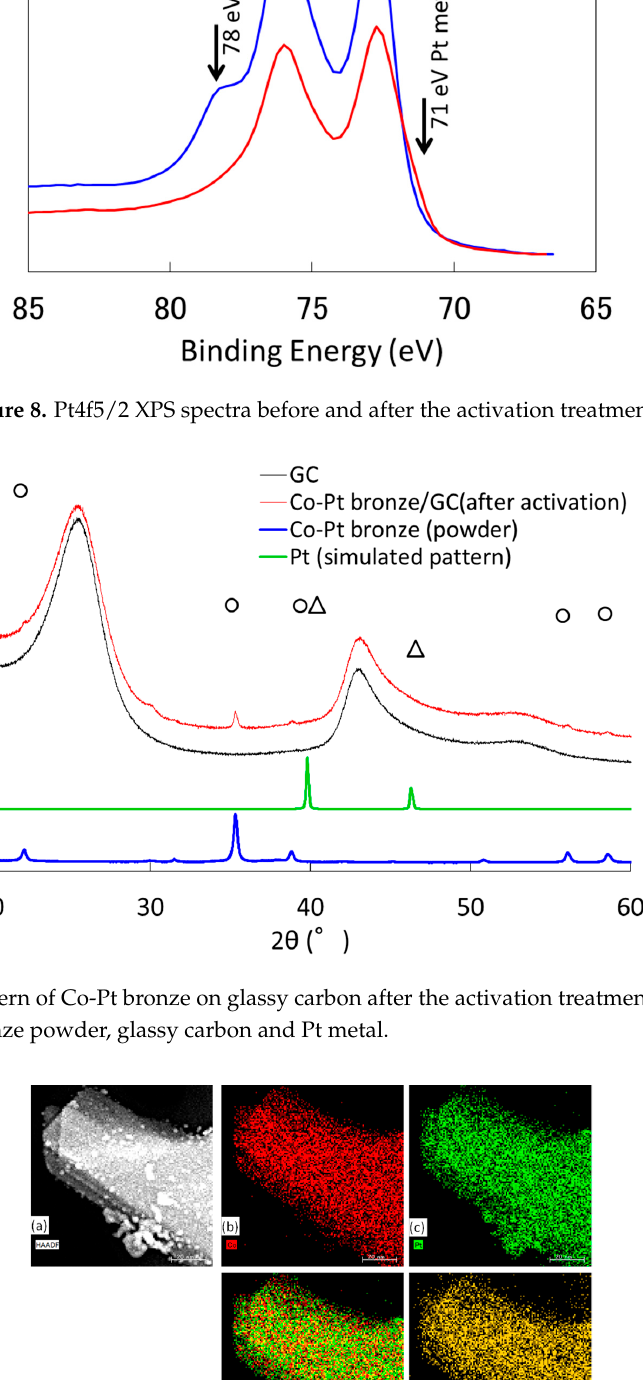
Figure 10. EDS analysis of activated Co-Pt bronze. ( a ) HAADF; ( b ) Co; ( c ) Pt; ( d ) Co and Pt; and ( e ) O images.